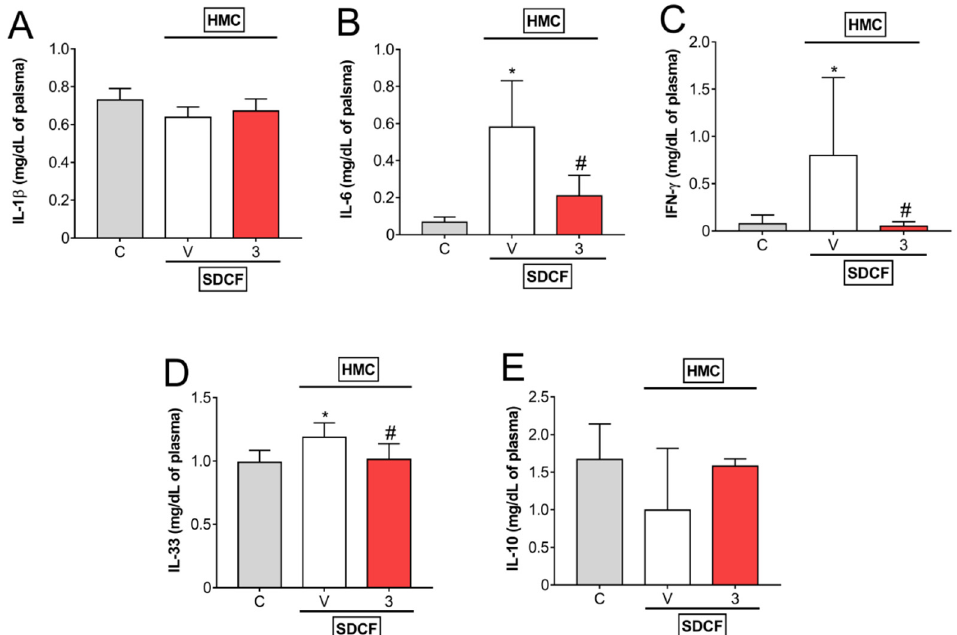
Figure 3. HMC inhibits SDCF-induced IL-6, IFN- γ , and IL-33, but does not change IL-1 β and IL-10 plasmatic levels. Blood was collected 24 h after the administration of SDCF for the evaluation of IL-1 β ( A ), IL-6 ( B ), IFN- γ ( C ), IL-33 ( D ), and IL-10 ( E ) levels. Results are expressed as mean ± SD, n = 6 mice per group per experiment, and are representative of two independent experiments. * p < 0.05 vs. control (C) group; # p < 0.05 vs. vehicle (V) treated group; one ANOVA followed by Tukey’s post hoc test.